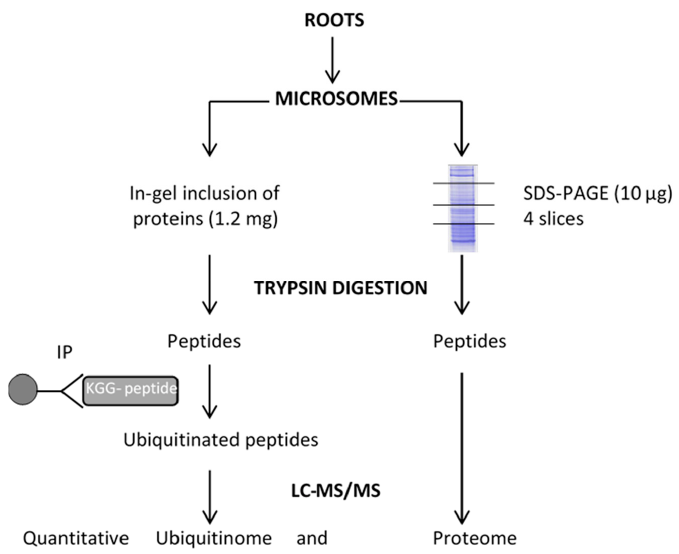
Figure 1. Workflow for quantitative profiling of the proteome and the ubiquitinome in Arabidopsis root membrane proteins upon mannitol treatment. LC-MS/MS: liquid chromatography–tandem mass spectrometry. IP: immunopurification .